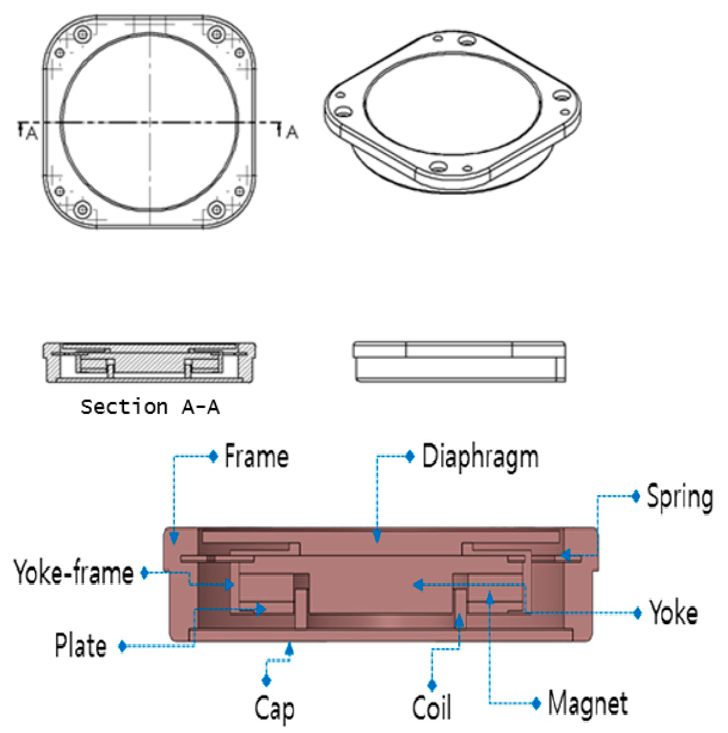
Figure 1. Design model of virtual engine sound actuator.